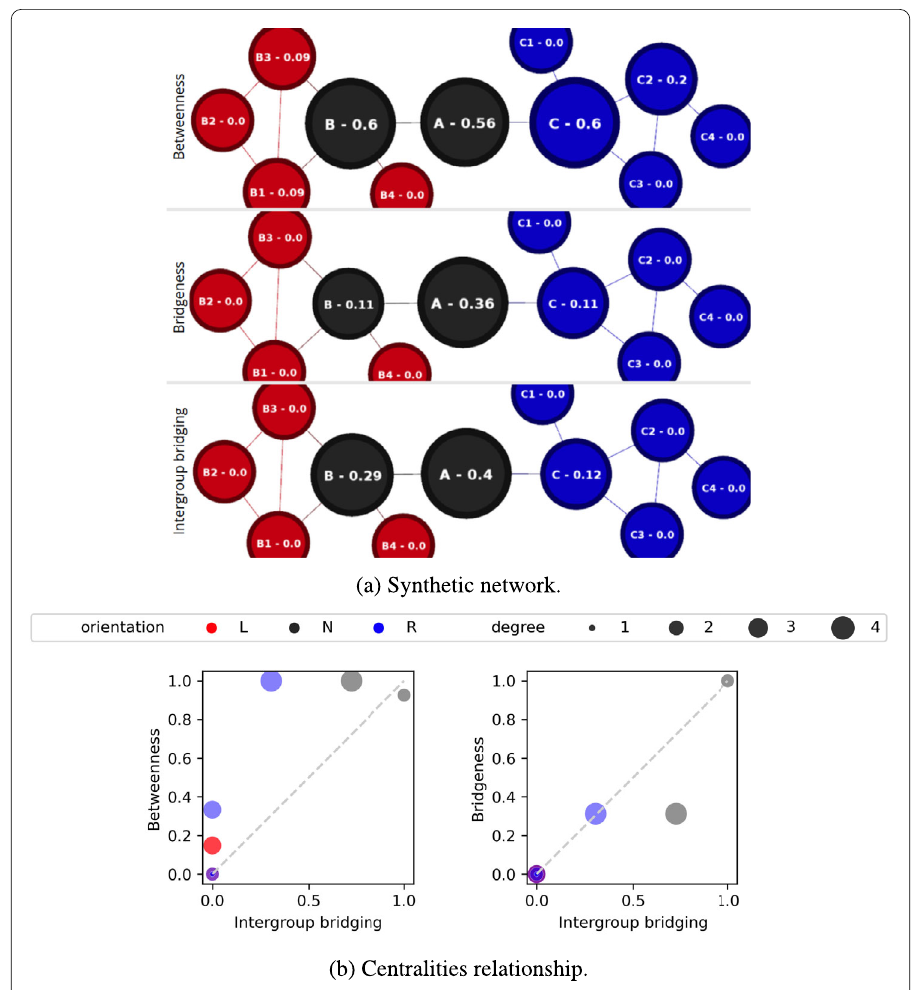
Figure 1 Centralities comparison on a synthetic network